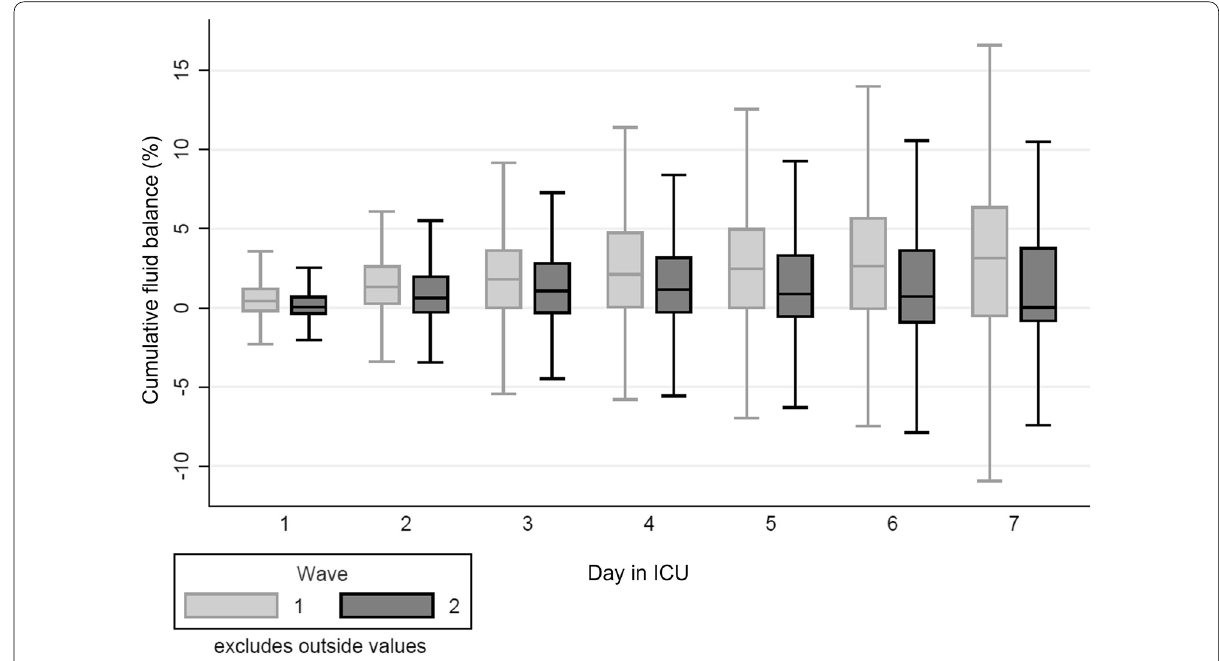
Fig. 3 Comparison of daily cumulative fluid balance by COVID-19